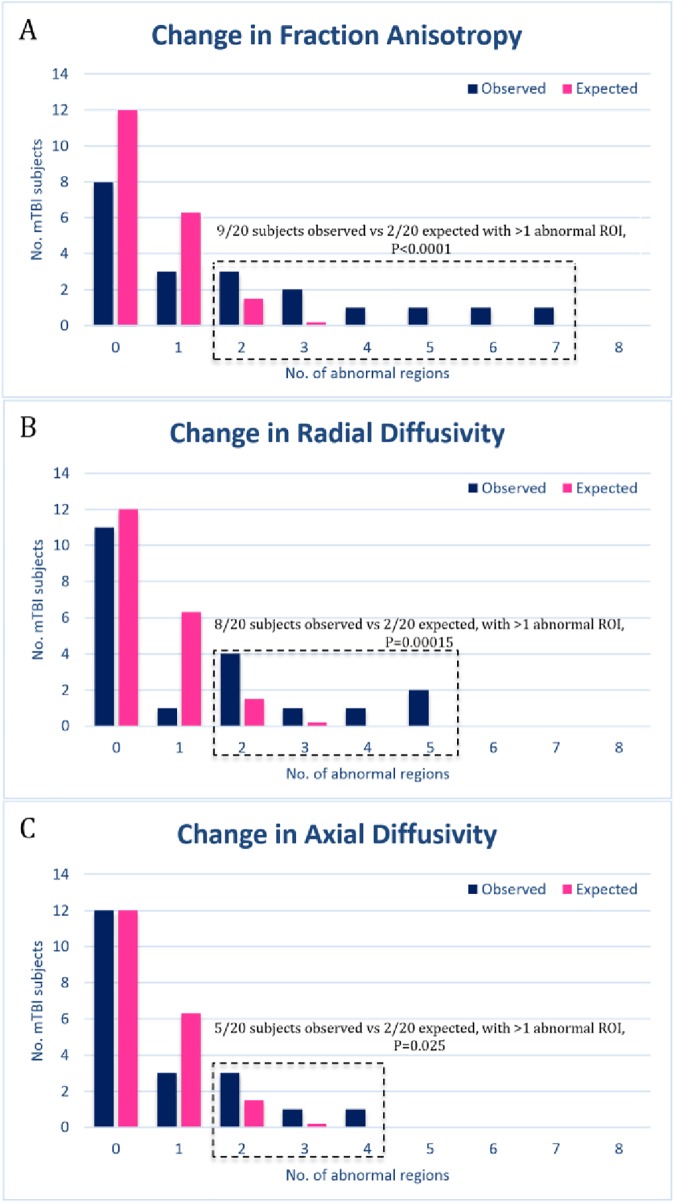
Number of abnormal regions of interest in mild traumatic brain injury (mTBI) subjects.Abnormal regions are defined as having DTI metrics more than 2 standard deviations above or below the mean for the control group. Blue bars indicate the number of mTBI subjects with a given number of abnormal regions. Pink bars indicate the number of subjects that would be expected by chance, based on a binomial distribution with n = 11 regions, p = 0.0455. Regions are assumed to be independent. Dashed boxes indicates metrics in which the number of mTBI subjects with more than one abnormal region is significantly different to that expected by chance (binomial distribution, n = 20 subjects, p = 0.0867) [8]. (A) Number of abnormal changes in fractional anisotropy in mTBI subjects. (B) Number of abnormal changes in radial diffusivity. (C) Number of abnormal changes in axial diffusivity.